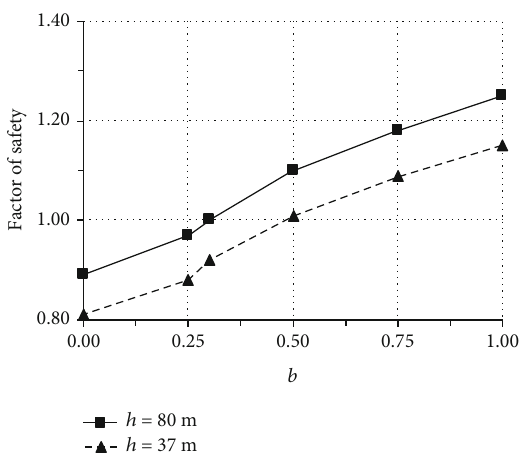
Figure 11: Relationship between FOS and b under the groundwater levels in 1976 and 1992.